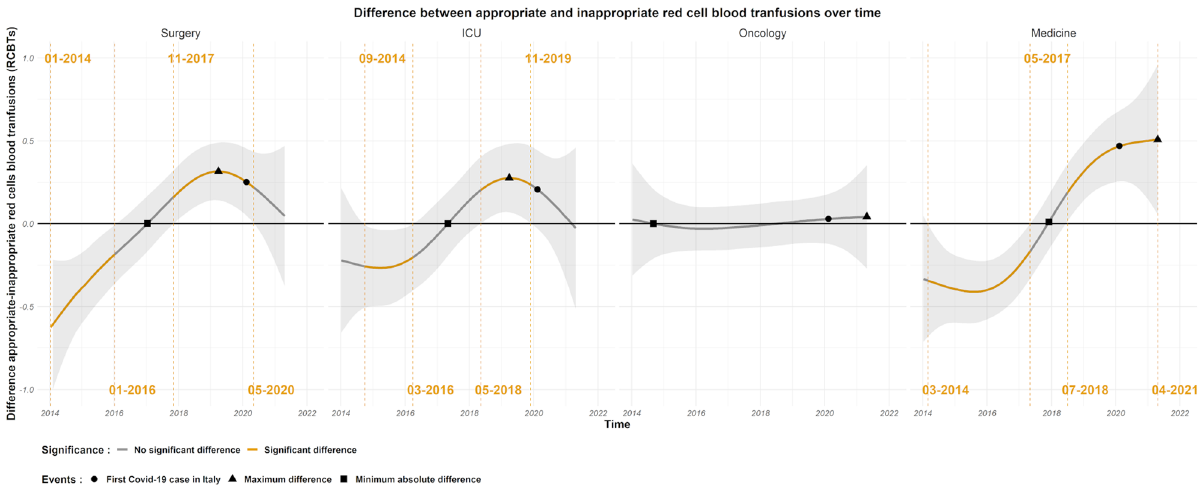
Figure 2. Average (across hospitals) difference in the smooth time trend between appropriate and inappropriate RBCTs in the surgical (SURG), intensive care unit (ICU), oncology (ONC) and medical (MED) wards. Time periods of significant difference (zero not included in the 95% CI) between the two smooth components are highlighted in yellow. The timepoint of the maximum difference between the two smooth components is visualized by a triangle, the time of zero difference by a square, and the first reported COVID-19 case in the region is represented by a circle.